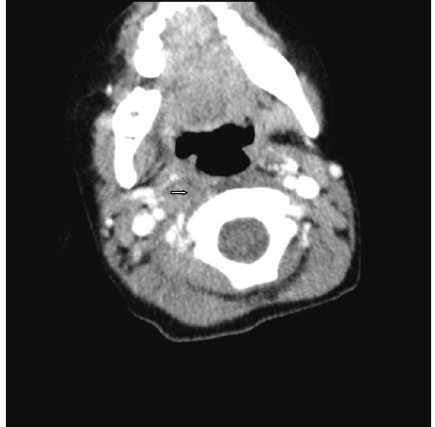
Figure 2: Asymmetric thickening of the right parapharyngeal soft tissue (arrowhead).